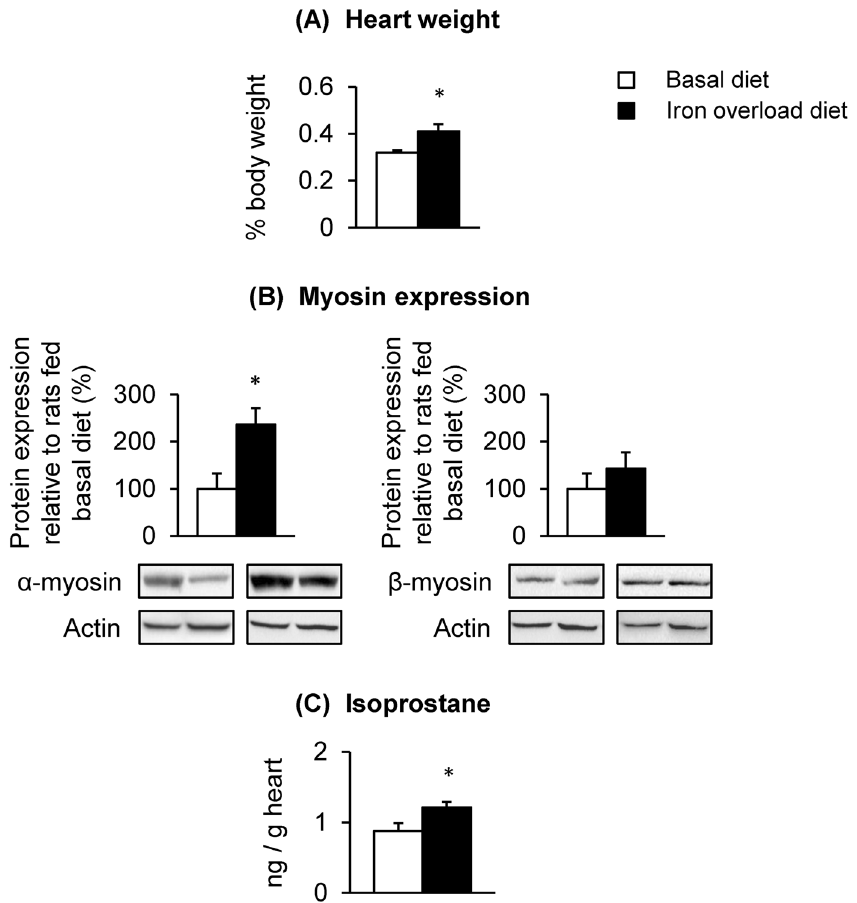
Figure 6. Effect of dietary iron overload on cardiac hypertrophy and oxidative stress in rats. Sprague-Dawley rats were fed basal diet (50 mg iron/kg diet) or iron overload diet (10,000 mg carbonyl iron/kg diet) for 5 weeks (n = 4 per group) to determine the heart-to-body weight ratios ( A ), levels of α - and β -myosin heavy chains ( B ) and isoprostane levels ( C ) in the heart. Data are presented as the means ± SEM. * p < 0.05 between rats fed basal diet and those fed iron overload diet assessed by the two-sample t